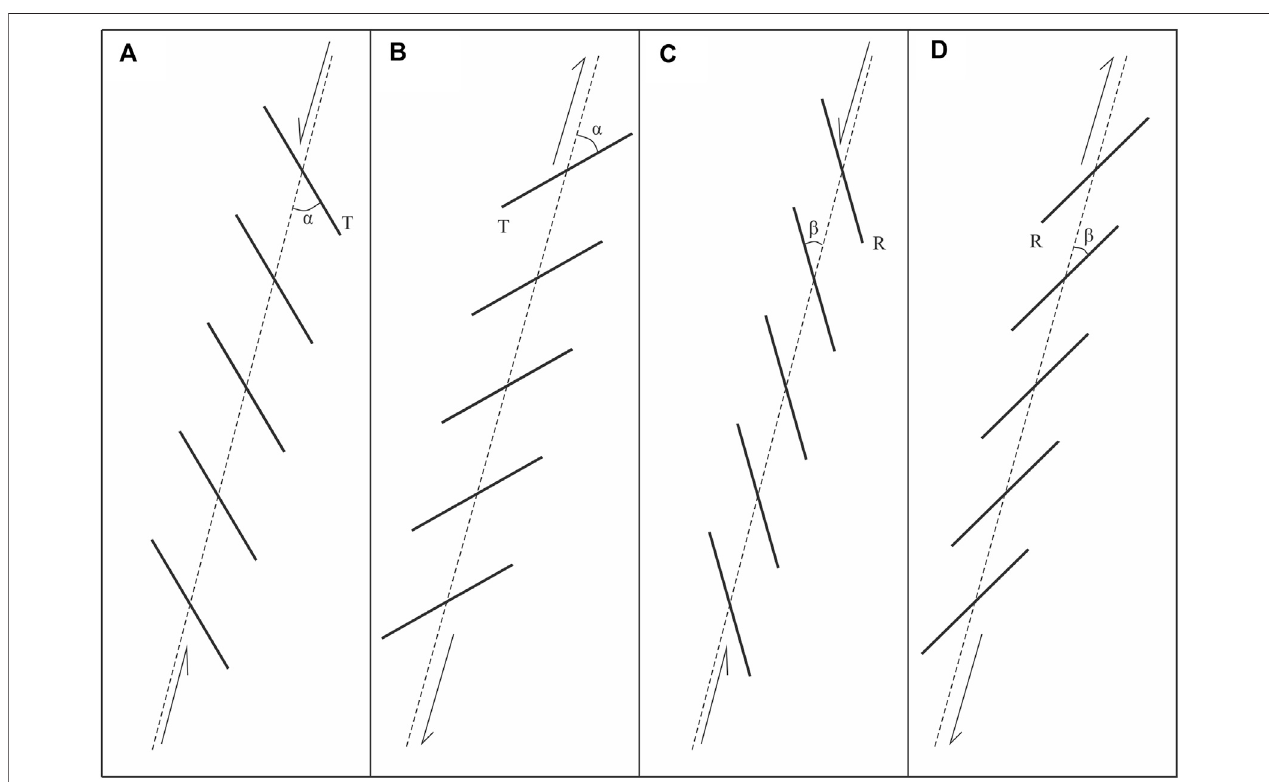
FIGURE 4 | Wrench directions and fault arraying types. (A) Right-stepping tensional faults indicating a sinistral strike-slip fault system, (B) Left-stepping tensional faults indicating a dextral strike-slip fault, (C) Right-stepping R-shear faults indicating a sinistral strike-slip fault system, (D) Left-stepping R-shear faults indicating a dextral strike-slipfaultsystem. α istheanglebetweenthedirectionofprincipal displacementzoneand theTfracture, and β istheanglebetweenthedirectionofprincipal displacement zone and